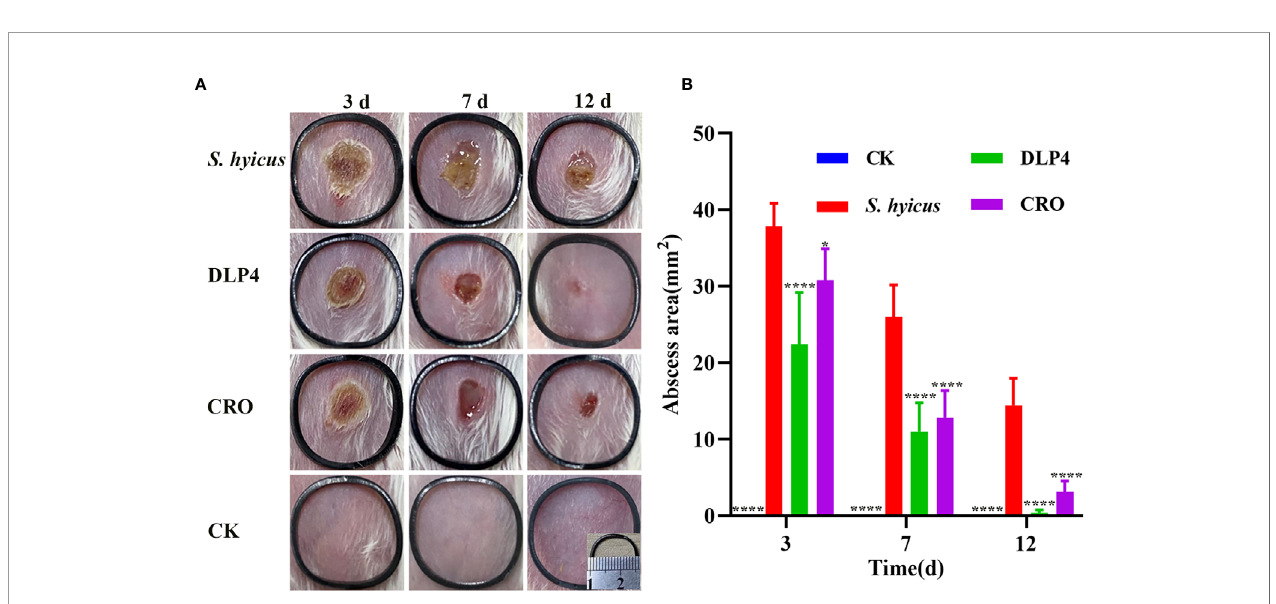
FIGURE 5 | The therapeutic effect of DLP4 in mouse model of cutaneous abscesses induced by S. hyicus ACCC 61734. Six weeks BALB/c mice were subcutaneously injected with S. hyicus ACCC 61734, and followed by the treatment with DLP4 and ceftriaxone (CRO) at 1 d after infection. (A) Photographs of abscess at days 3, 7, and 12 after challenge with S. hyicus ACCC 61734, the length and width of the black ring are 1.6 cm. (B) The abscess area of different groups, results were given as mean ± SD (n = 5), all data were analyzed by the one-way ANOVA and Bonferroni multiple comparison, *P < 0.05; ****P <